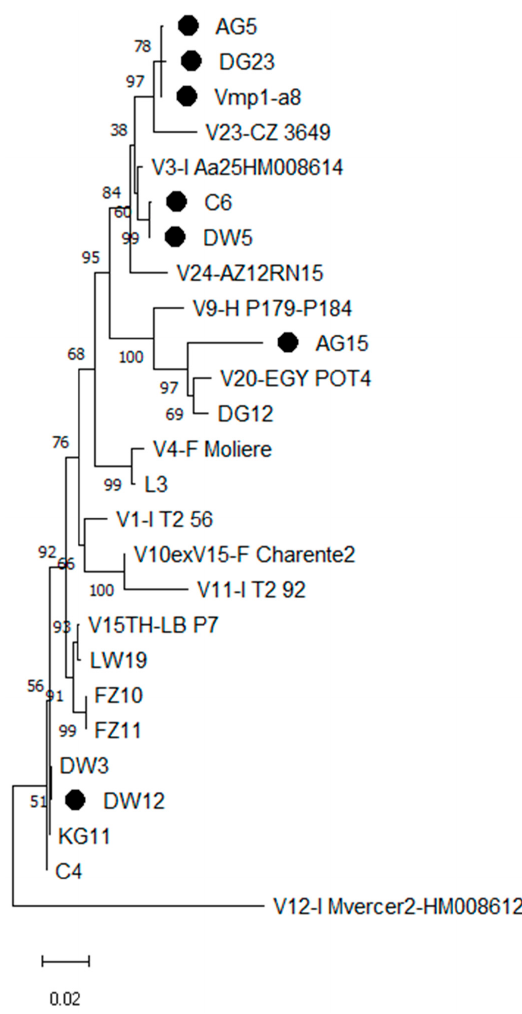
Figure 1. Phylogenetic tree inferred from the ‘ Candidatus Phytoplasma solani’ strain nucleotide sequences of the vmp 1 gene. The evolutionary history was inferred using the maximum parsimony method. The MP tree was obtained using the Subtree–Pruning–Regrafting (SPR) algorithm. The percentage of replicate trees in which the associated taxa clustered together in the bootstrap test (500 replicates) are shown next to the branches. The names of phytoplasma strains included in the phylogenetic analysis are given in the tree image. The GenBank accession numbers of the sequences are given; the gene sequences obtained in our investigation are indicated by filled circles.